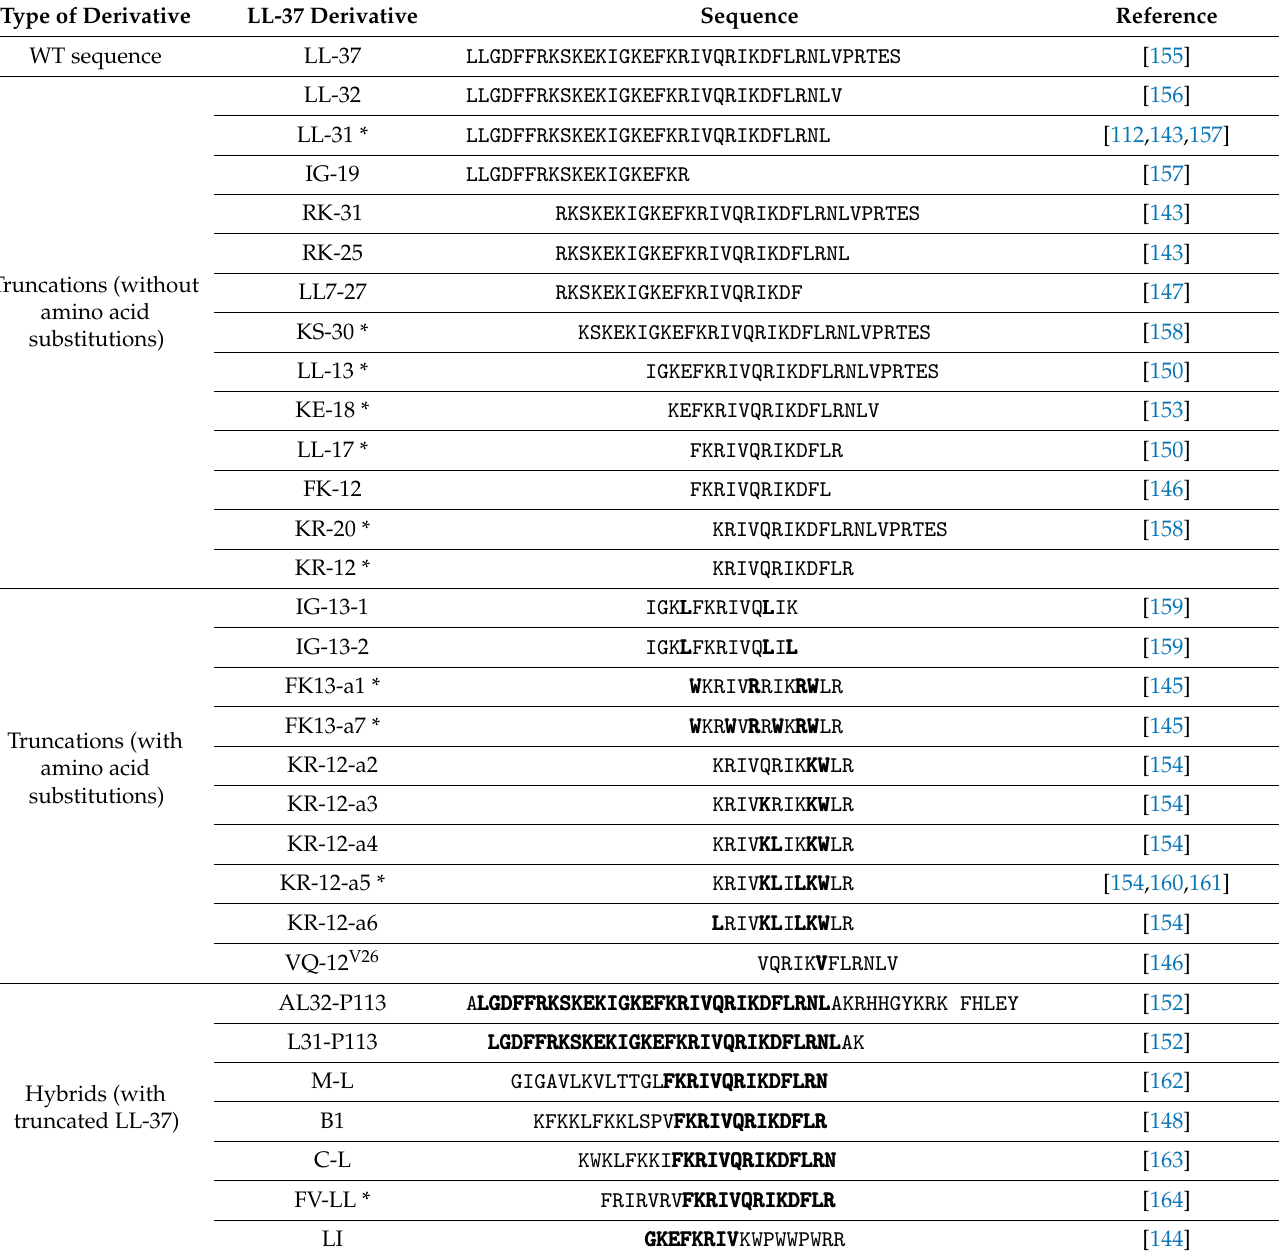
Table 2. LL-37 derivatives that display enhanced antimicrobial activity when compared to the LL-37 parent